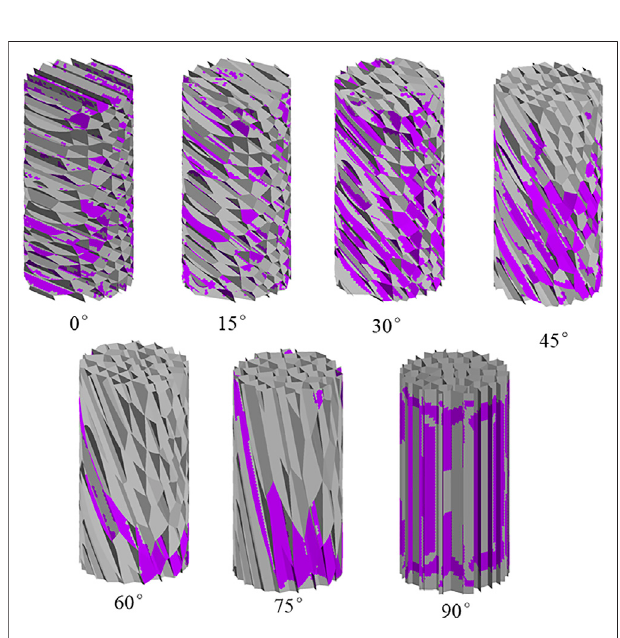
FIGURE 4 | Spatial distribution of failure elements on the column